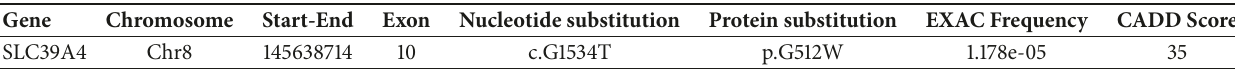
Table 1: “R” software was used to identify the deleterious zinc transporter gene in B03. An EXAC frequency of < 0.01 and CADD score of > 10 were accepted. Excluding synonymous variants, at position Chr8:145638714 of the SLC39A4 gene, c.G1534T and p.G512W, portrayed as a rare mutation in comparison to other identified genes and genetic variants. Note. Please see Sup Materials 2 for complete list of zinc transporter genes derived by “R” software for